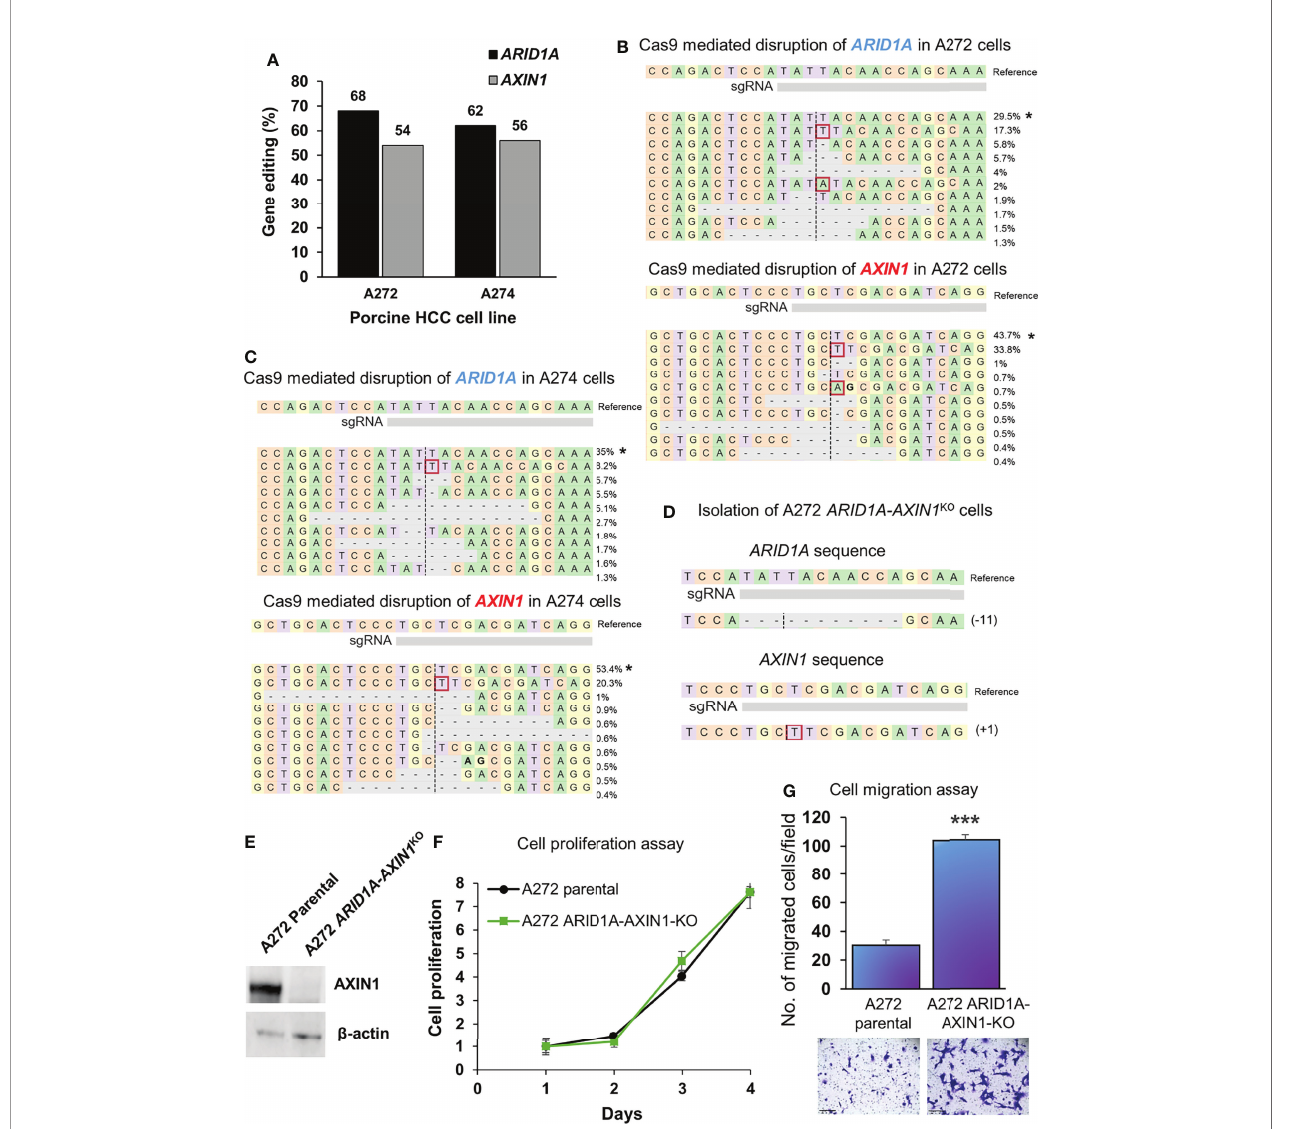
FIGURE 6 | Simultaneous knockout of ARID1A and AXIN1 in Oncopig HCC cells increases the migration, but does not alter the proliferation of porcine HCC cells. (A) CRISPR/Cas9-induced editing of AXIN1 and ARID1A in A272 and A274 porcine HCC cells using AXIN1 gRNA#2 and ARID1A gRNA. Genomic DNA was collected two days post-transfection and analyzed by targeted NGS. The bar graph depicts the percentages (%) of total reads that displayed indels at the gRNA target site. (B, C) Top 10 reads detected by targeted NGS analysis in the two porcine HCC lines mapped to the reference sequence. The percentage of reads of each sequence are shown on the right. The asterisk (*) indicates/marks non-edited reads.. Dashed line, predicted Cas9 cleavage position; red box, insertion; dash, deleted base. (D) NGS Analysis of ARID1A-AXIN1 KO single cell clone isolated from A272 porcine HCC cells transfected with Cas9, AXIN1 gRNA#2, and ARID1A gRNA. Dashed line, predicted Cas9 cleavage position; red box, insertion; dash, deleted base. (E) Con fi rmation of complete loss of AXIN1 protein in A272 ARID1A- AXIN1 KO porcine HCC cells by Western blotting. The cells were lysed two days post-transfection and analyzed using an anti-AXIN1 antibody. b -actin was used as a loading control. (F) Cell proliferation was determined for A272 parental and ARID1A-AXIN1 KO cells by MTS assay. Cell viability at different time points (days) was measured and expressed as A 490 normalized to values of day 1. Statistical analysis was conducted to compare viability of the different cell lines at each time point by two-way ANOVA. No signi fi cant difference was detected between the cell lines at p < 0.05. (G) Migration of A272 ARID1A-AXIN1 KO cells in comparison to parental cells was assessed by transwell cell migration assay. Quantitated migration ability is presented as the number of migrated cells per fi eld. Values in the bar graph represent mean ± S.E. (n = 6 fi elds). ***, p < 0.0001. Representative images of migrated cells stained with crystal violet are shown below each bar graph. Scale bar, 250 m